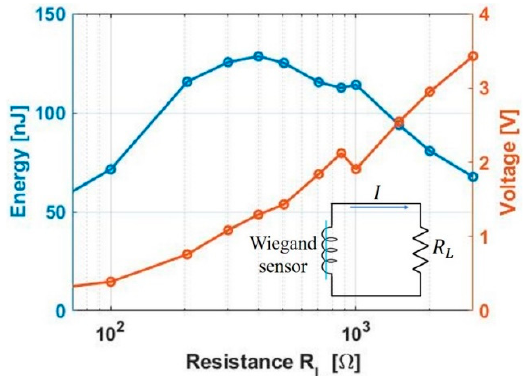
Figure 3. Energy consumption in the load resistor R L from a single Wiegand voltage pulse and corresponding voltage drop.